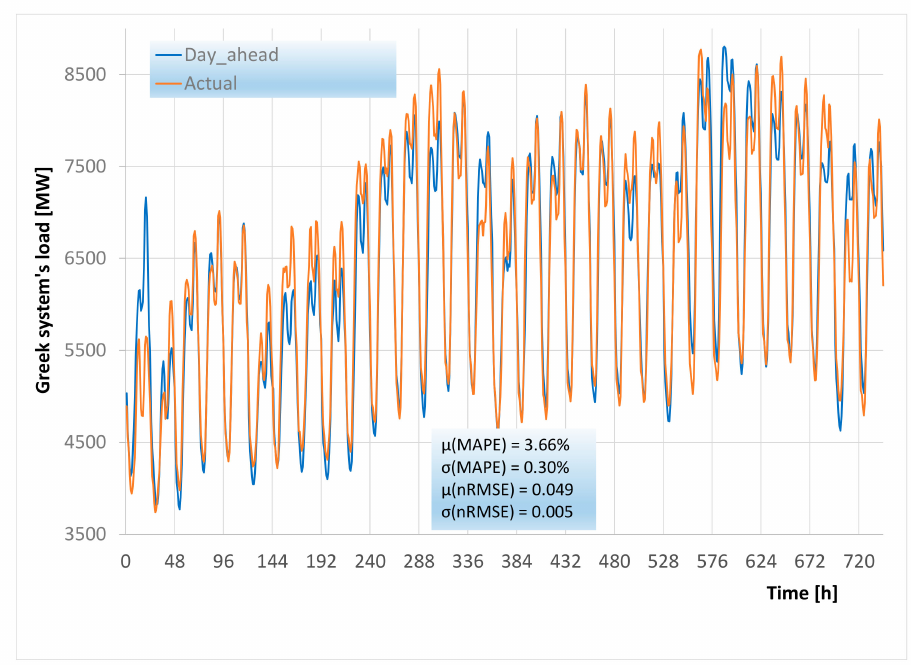
Figure 12. Prediction with the FF ANN and validation of the Greek system’s demand for January 2022. MAPE and nRMSE means and standard deviations refer to the full year